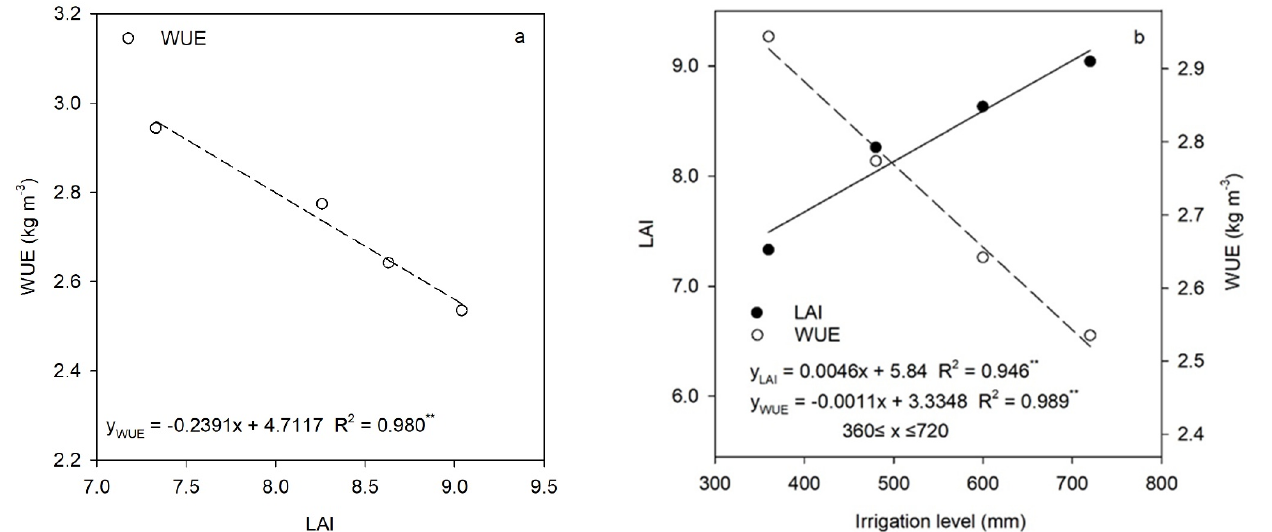
Figure 5. Relationships between optimal LAI and optimal water use efficiency (WUE) ( a ), and between irrigation level and optimal LAI and WUE ( b ). ** denotes significance at the 0.01